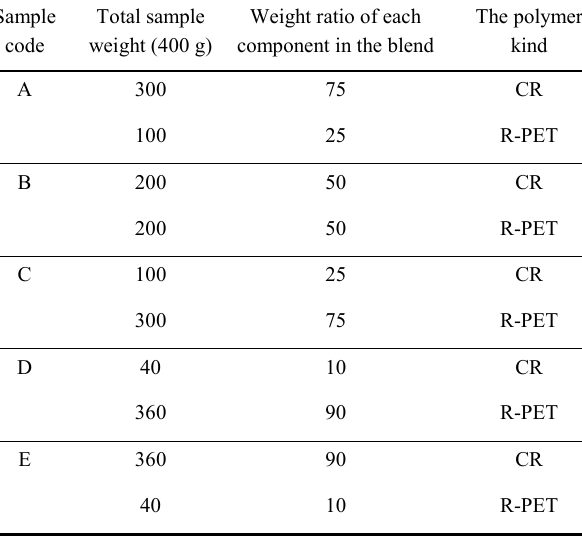
Composition of the blends prepared in the